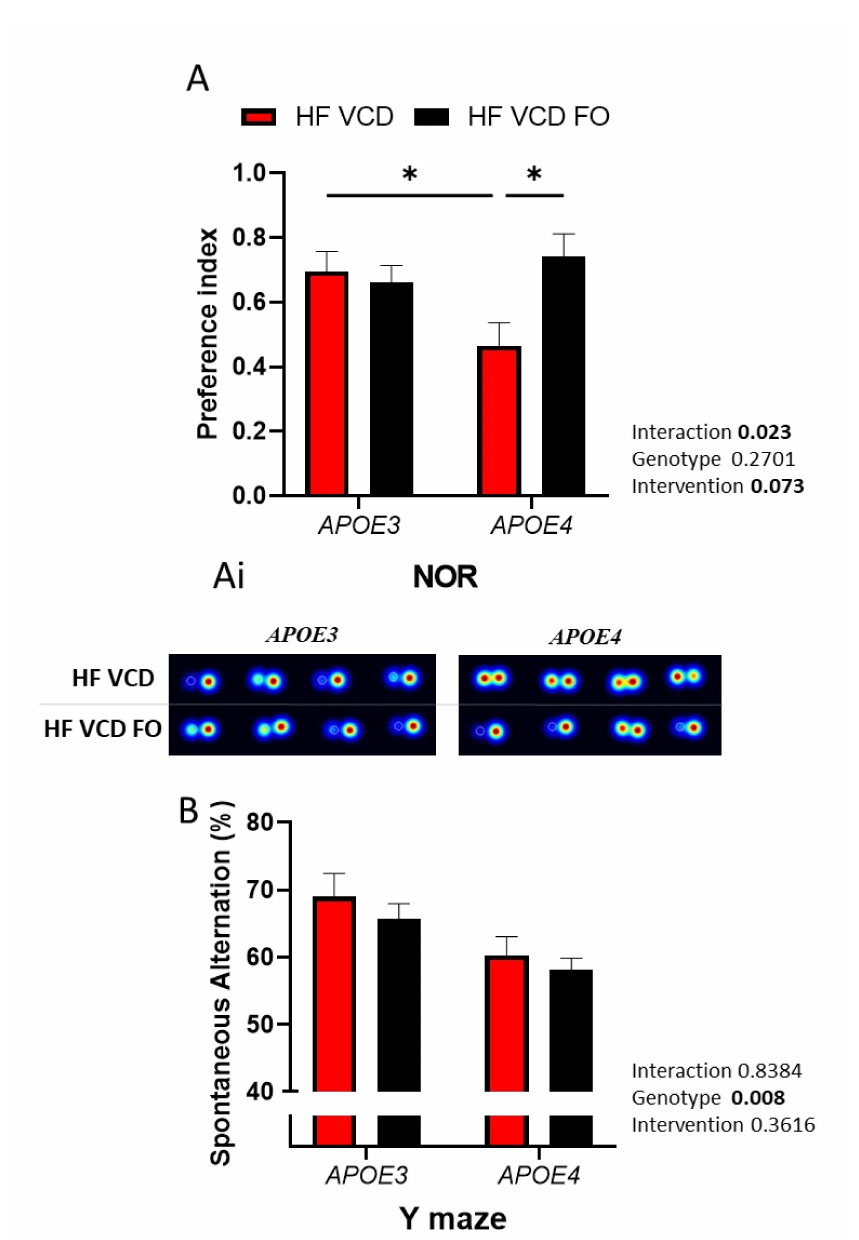
Figure 2. The effect of fish oil (FO) supplementation on cognitive performance: ( A ) Recognition mem- ory was improved via FO supplementation ( n ≥ 6); ( Ai ) representative heatmaps of the performance of individual animals. ( B ) The Y-maze performance diminished under APOE4 genotype and was not influenced by FO supplementation. Data are presented as mean ± SEM; * p <